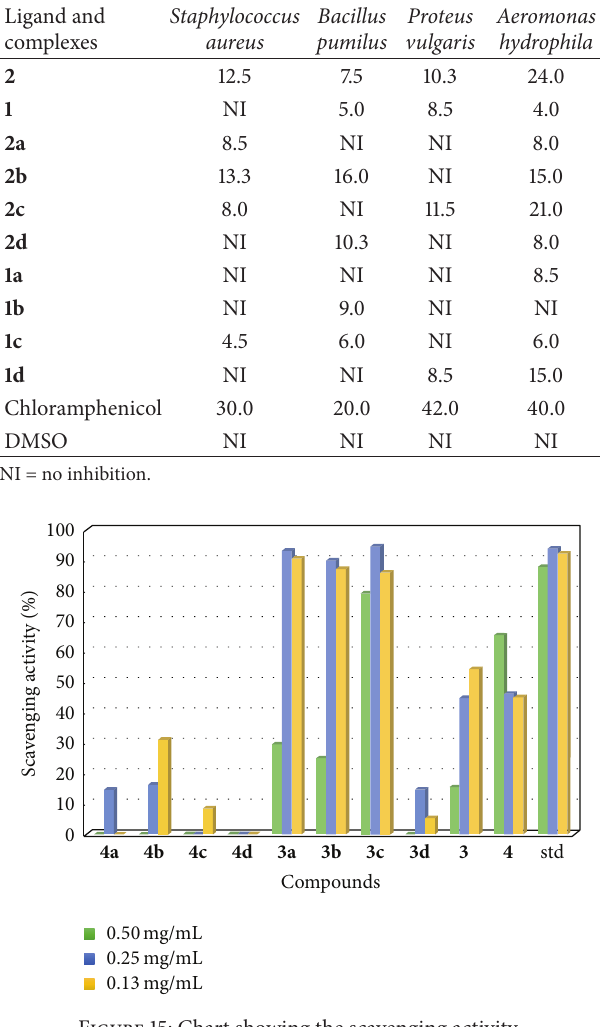
Figure 15: Chart showing the scavenging